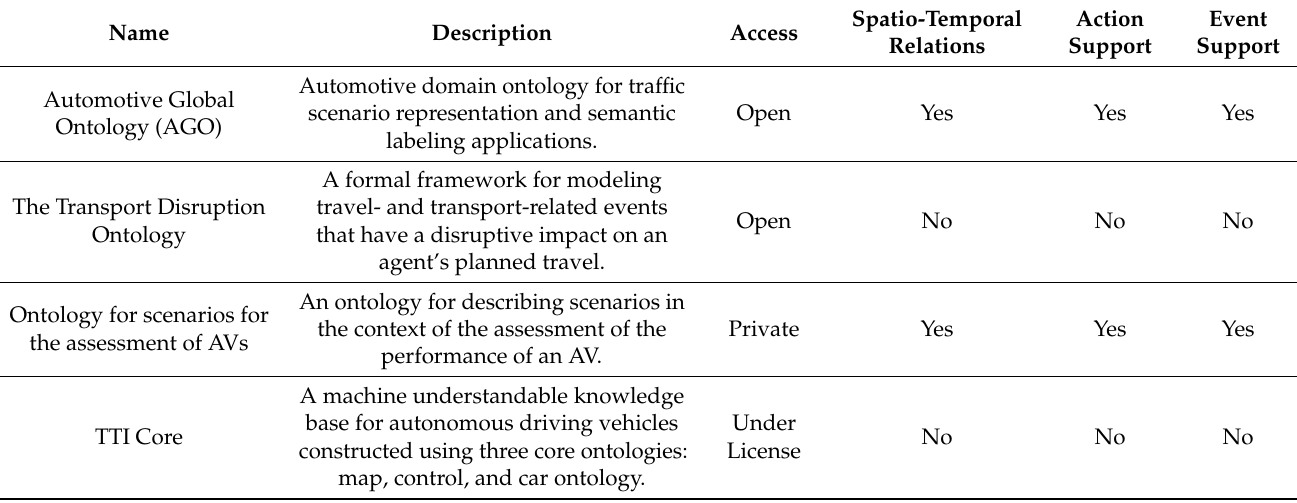
Table 5. Comparison of AGO with existing